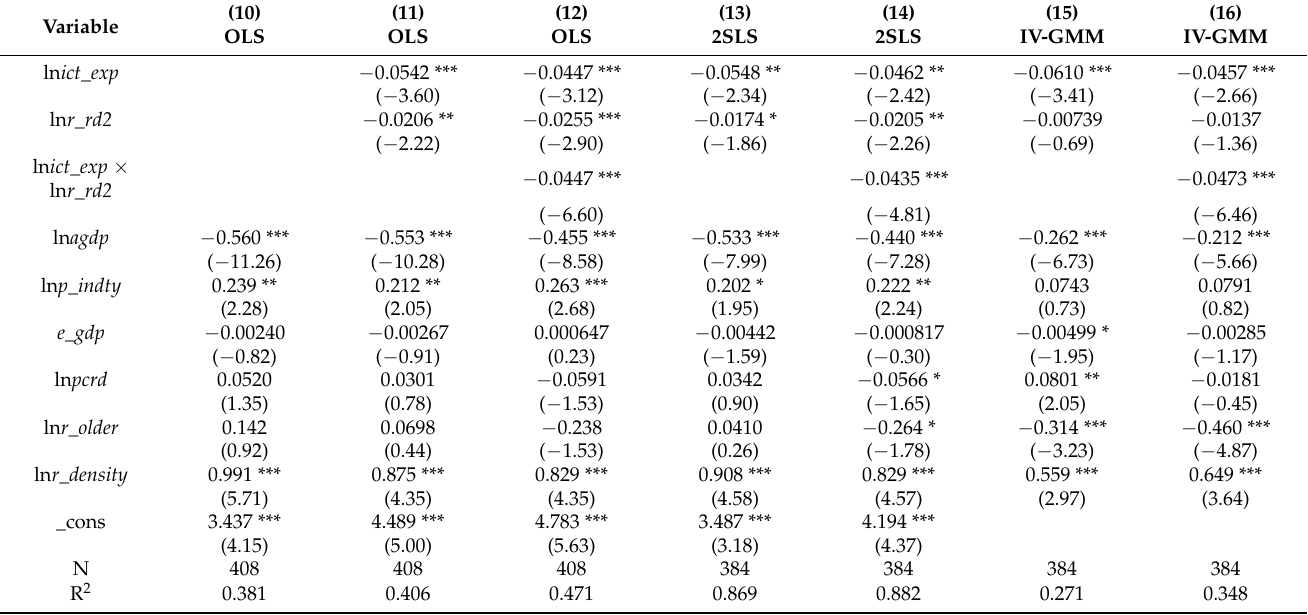
Table 6. Estimated results of the moderating effect of technological